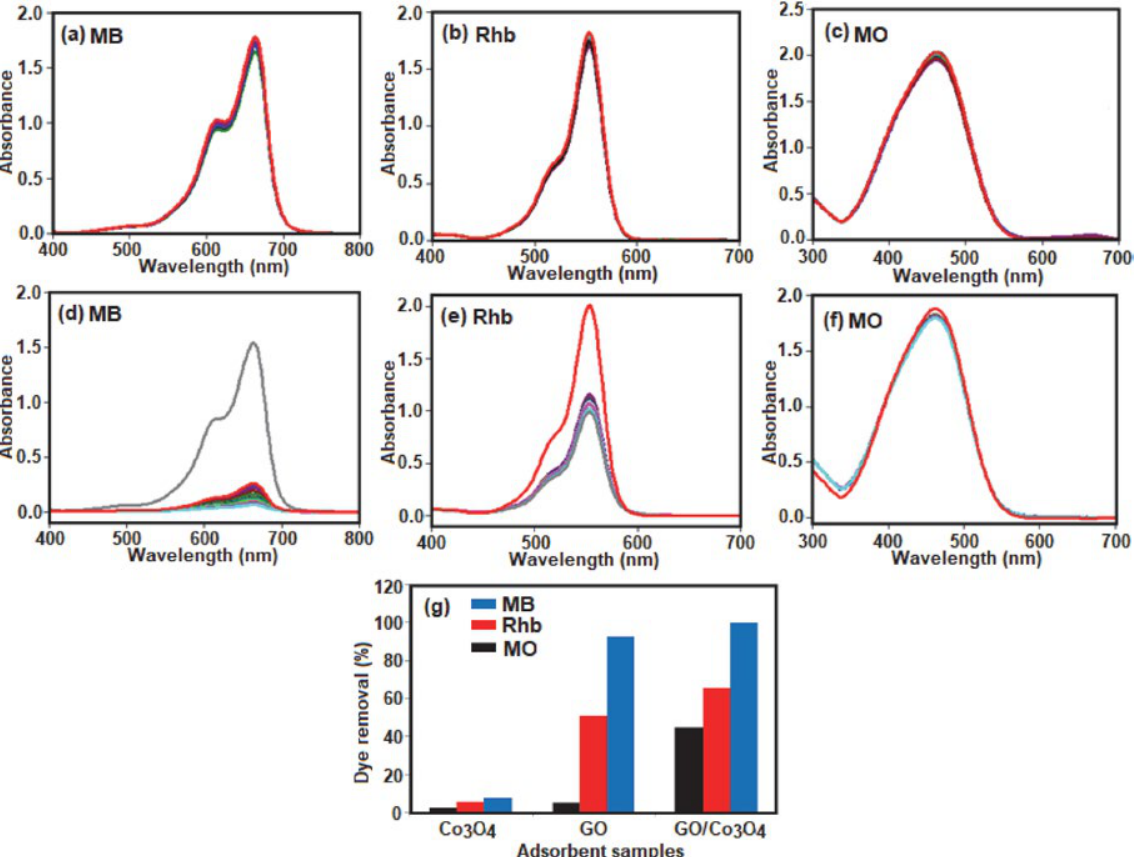
Figure 10 . The adsorption capabilities of (a)–(c) Co (g) Adsorption efficiency (%) of the dyes in the presence of different adsorbent